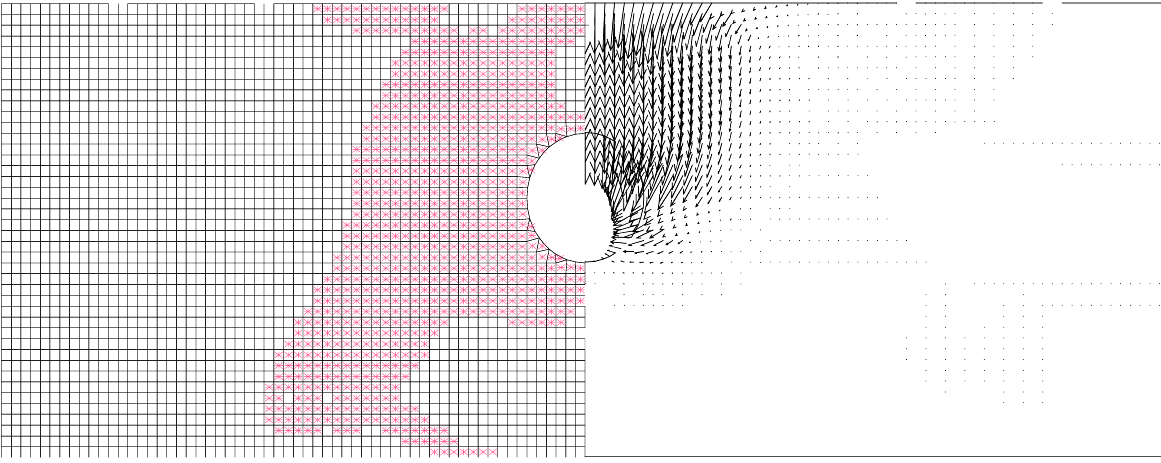
Figure 6. Plasticity ( left ), and velocity ( right ) plots at the stage of collapse ( C/D = 1, γD/S u = 3).